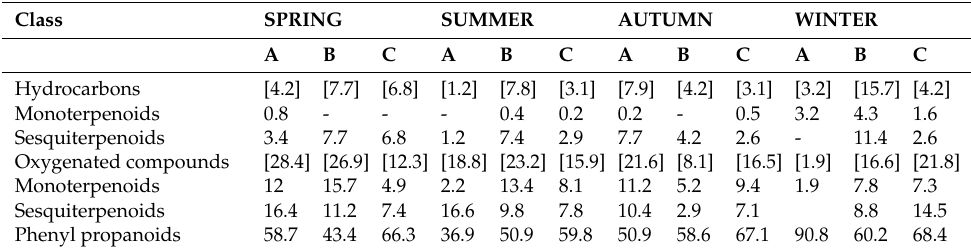
Table 4. Classes of compounds identified in ACREO from four seasons. A = Pithoragarhlocation (hilly region), B = Bhimtal location (sub hilly region), C = Pantnagar location (tarai region).